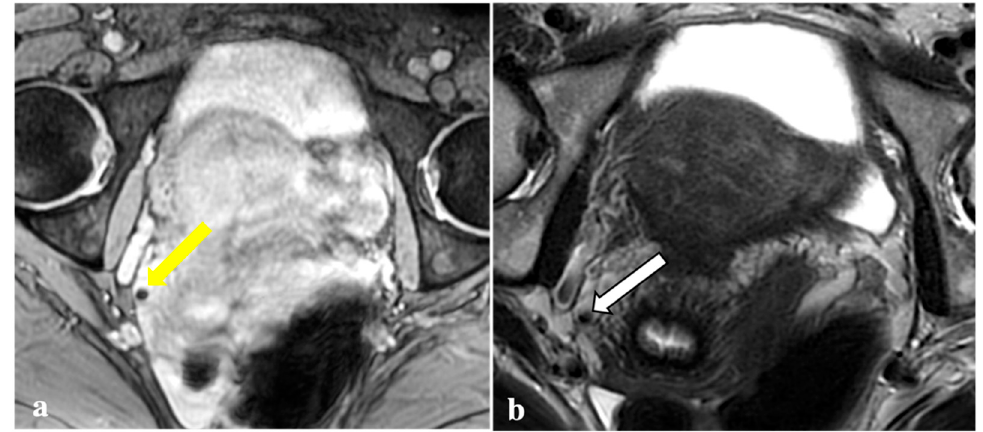
Figure 5. T2* ‐ weighted imaging pitfall. A punctate signal void on T2*W (yellow arrow) ( a ) observed in a 44 ‐ year ‐ old patient showed low signal in T2W (white arrow) ( b ) and in the other sequences (not shown). It was reported as a phlebolith by the expert reader.